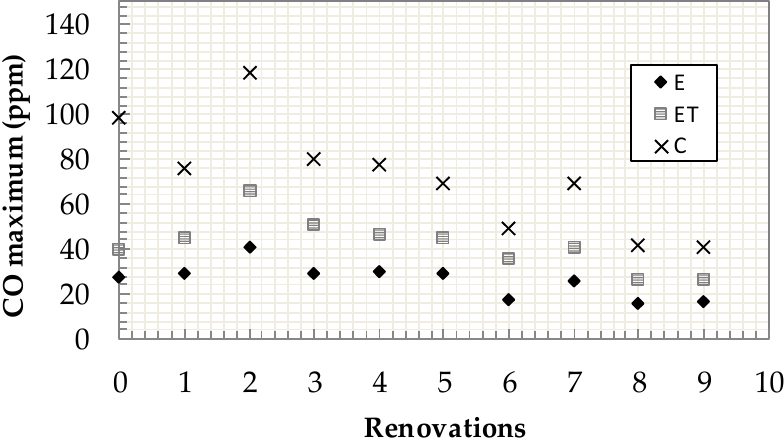
Figure 5. Maximum CO levels after 72 h (ppm) vs. renovations (experiment 2).